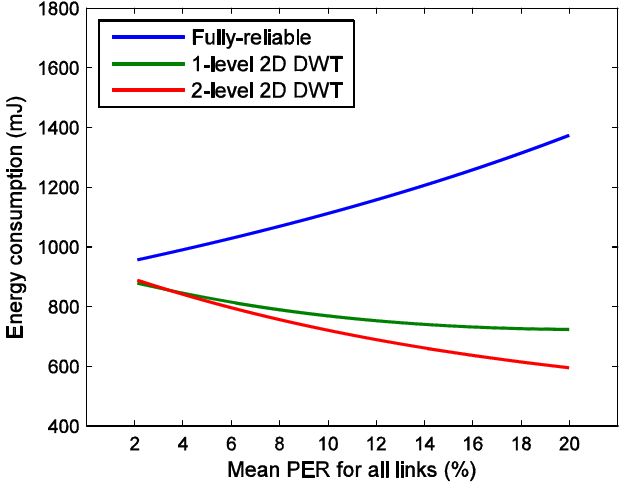
Figure 8. Energy consumption for a path composed of 10 intermediate nodes.